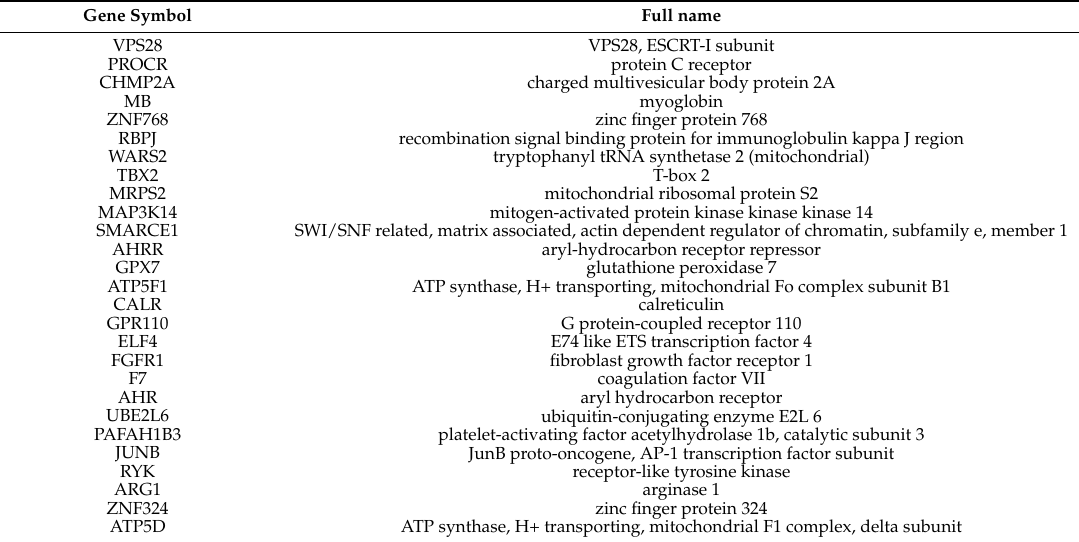
Table A2. Top 10 scored Genes in LINCS